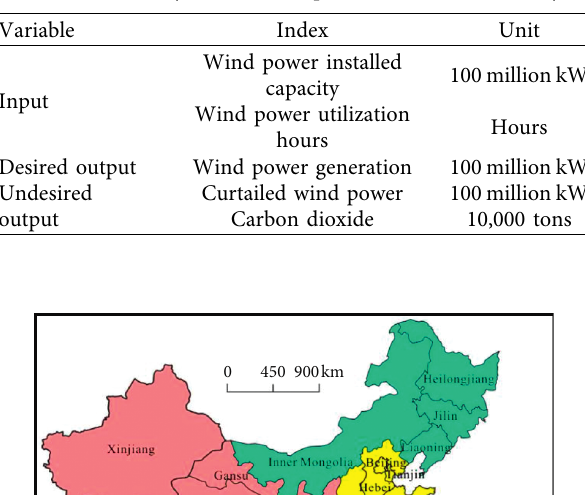
Figure 2: Development of the LSTM unit on the time axis. Table 1: Index system of wind power utilization efficiency.